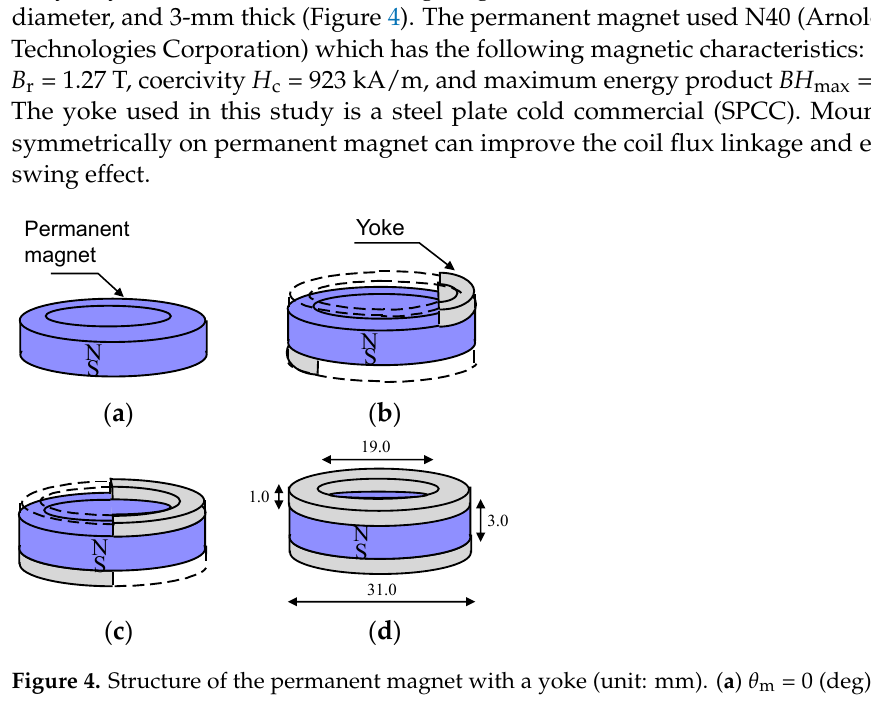
Figure 3. Swing-magnet-type generator. ( a ) External view; ( b ) Plan view; ( c ) Front view. The mover used a polystyrene cylinder as a floating body inside the ring magnet for buoyancy. The dimensions of the ring magnet were 19 mm inner diameter, 31 mm outer diameter, and 3-mm thick (Figure 4). The permanent magnet used N40 (Arnold Magnetic